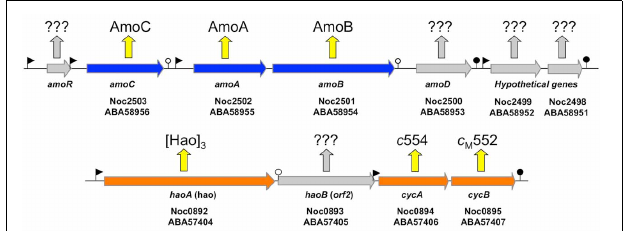
FIGURE 1 | Map of the amo gene cluster based on the genome sequence of N. oceani ATCC 19707. Filled arrows represent open reading frames . The promoters and transcriptional terminators are represented by flags and stem loops, respectively. Week terminators are indicated by an open circle. The amoR gene (not annotated in the genome and thus not represented on the array) is unique to Nitrosococcus oceani ( strain ATTC 19707, AFC27, AFC132, and C-27 ) and Noc2499 and Noc2498 are hypothetical genes conserved in the genome sequenced strains of all three species in the genus Nitrosococcus (N. oceani, N. watsonii, and N. halophilus) . Identified and hypothetical expression products are given by respective protein annotation or question marks,